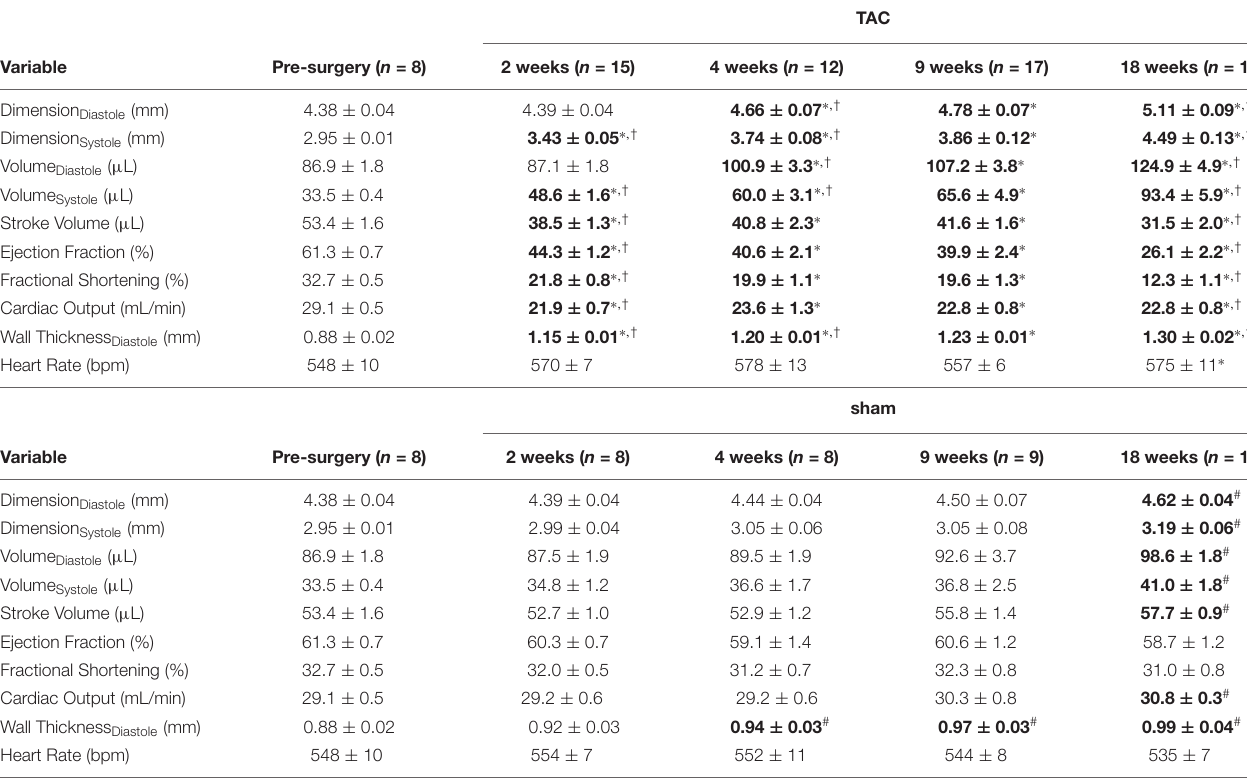
TABLE 5 | Expanded echocardiographic